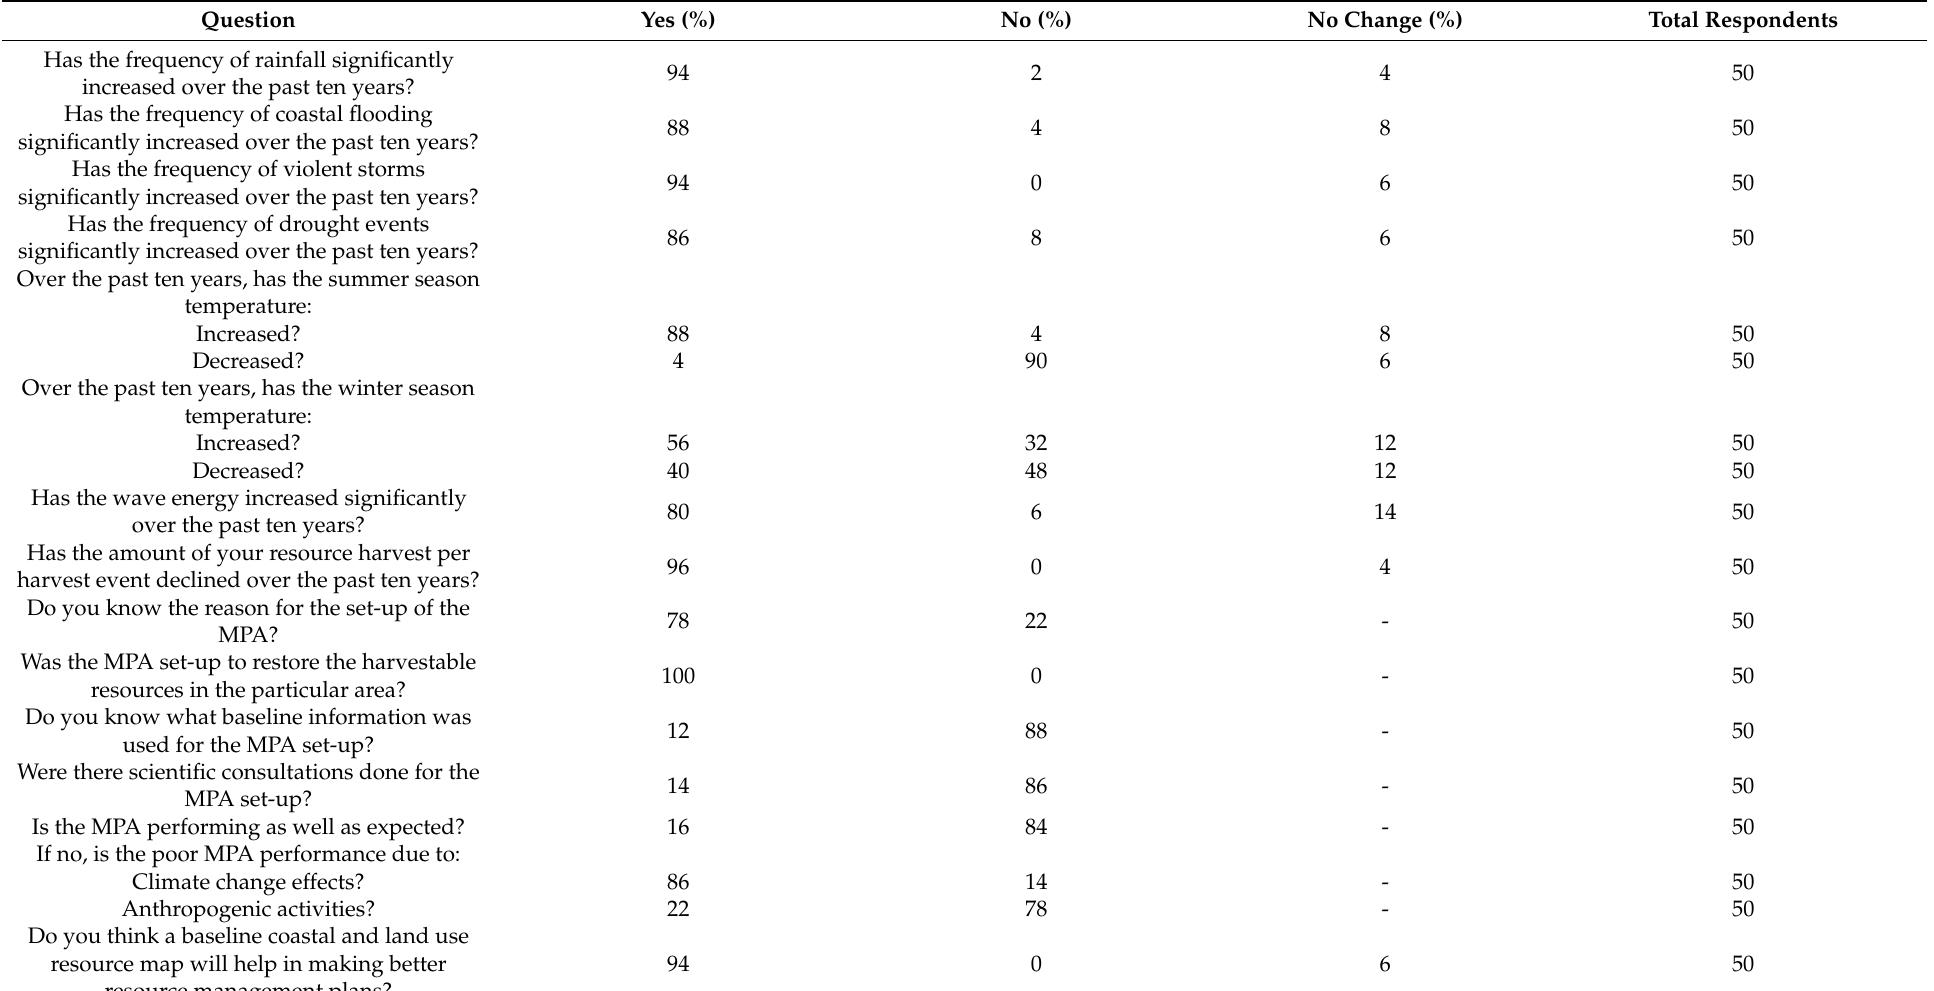
Table 3. Interviewees’ perceptions of climate change and Marine Protected